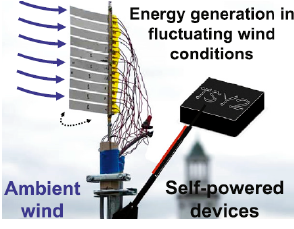
Figure 34. Principle of the PVDF EH generator based on an ‘inverted flag’ [195].